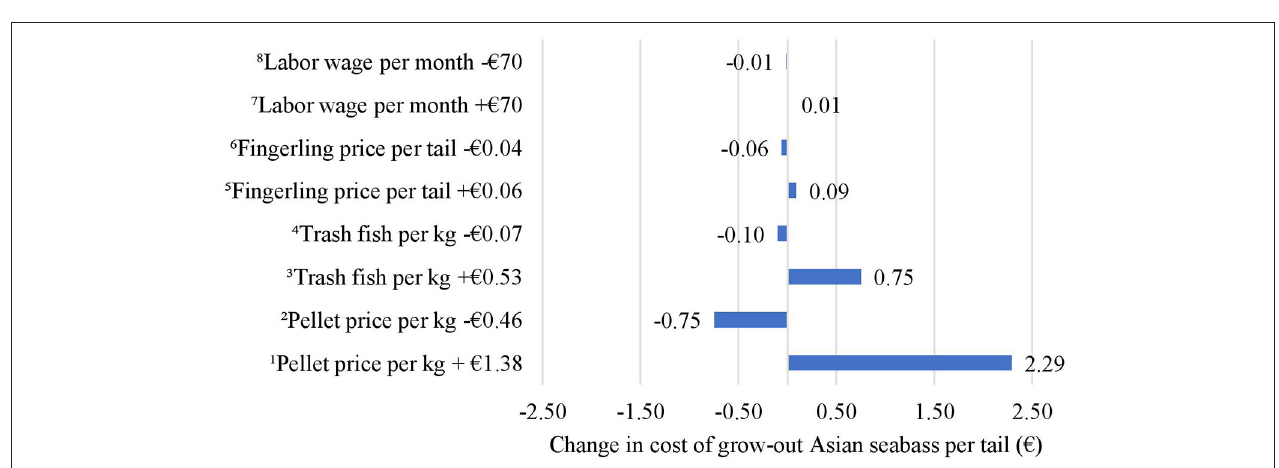
FIGURE 4 | Impact of changes in economic inputs on the costs of grow-out in Asian seabass per tail. 1 When the price of pellet per kilogram increases by e 1.38 from its default price, the costs of grow-out increase by e 2.29 per tail. 2 When the price of pellet per kilogram decreases by e 0.46 from its default price, the costs of grow-out decrease by e 0.75 per tail. 3 When the price of trash fish per kilogram increases by e 0.53, the costs of grow-out increase by e 0.75 per tail. 4 When the price of trash fish per kilogram decreases by e 0.07 less, the costs of grow-out decrease by e 0.10 per tail. 5 When the fingerling price per tail increases by e 0.06, the costs of grow-out increase by e 0.09 per tail. 6 When the fingerling price per tail decreases by e 0.04, the costs of grow-out decrease by e 0.06 per tail. 7 When the wage of labor per month increases by e 70, the costs of grow-out increase by e 0.01 per tail. 8 When the wage of labor per month decreases by e 70, the costs of grow-out decrease by e 0.01 per